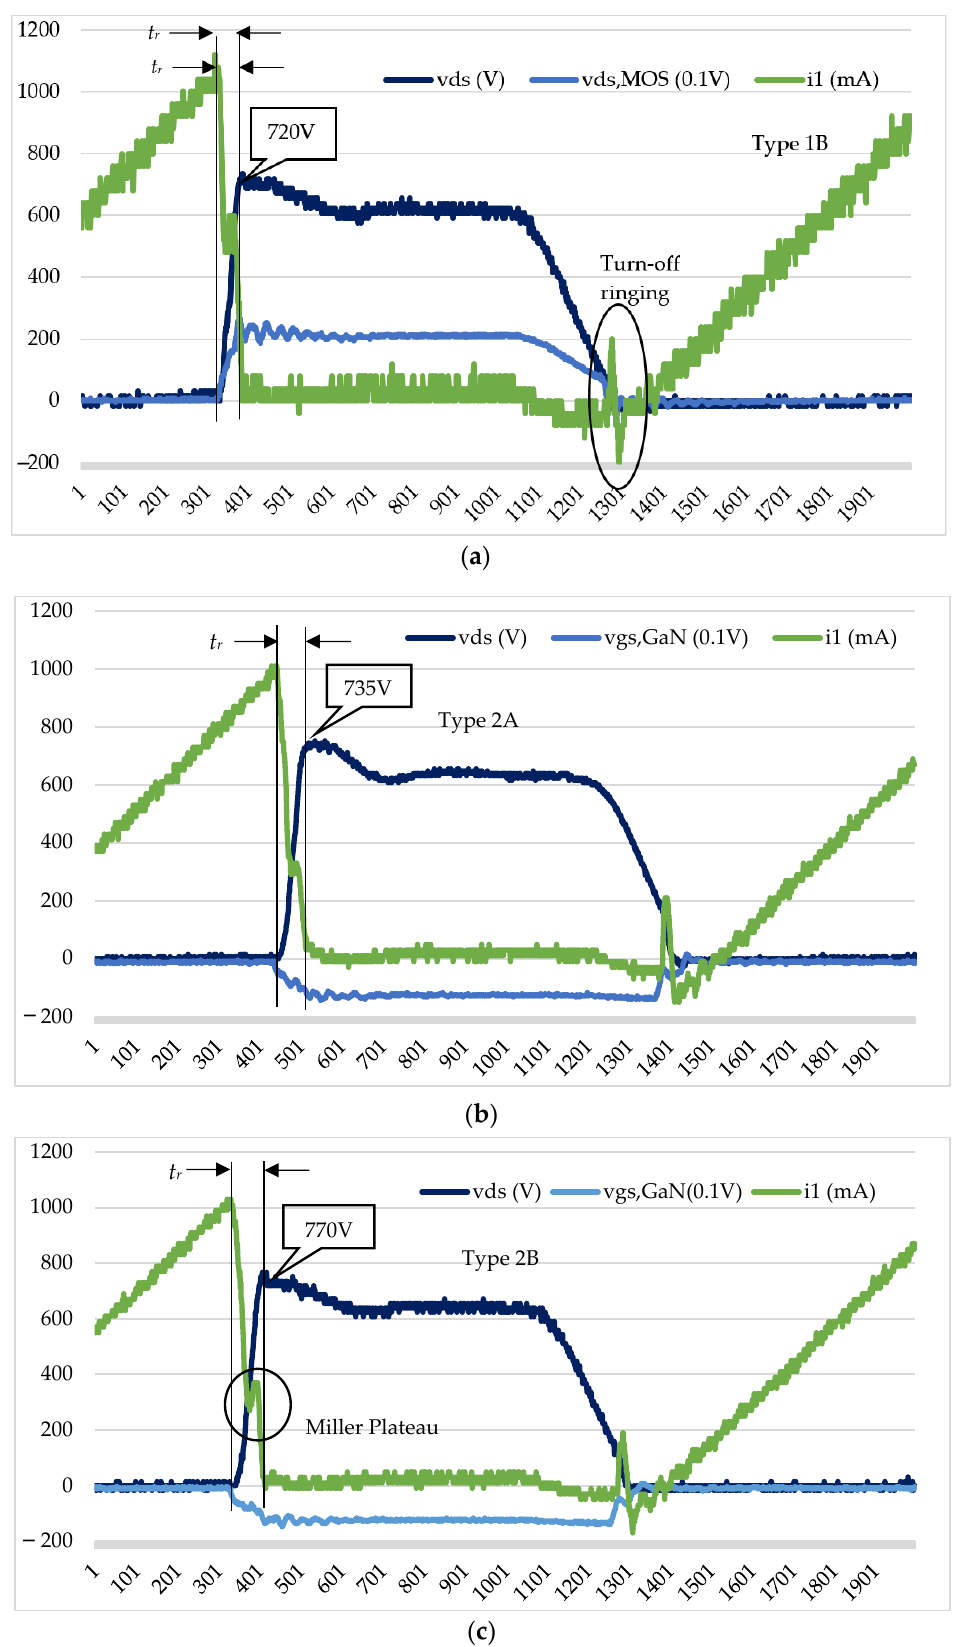
Figure 12. DCM V DD = 300 V, duty = 48%, Ro = 50 Ω , switching frequency = 280 kHz. ( a ) Type 1B, ( b ) Type 2A, ( c ) Type 2B. (x-axis value: time ( a – c ): 2 ns per tick). Table 5. Output parasitic capacitance estimation.